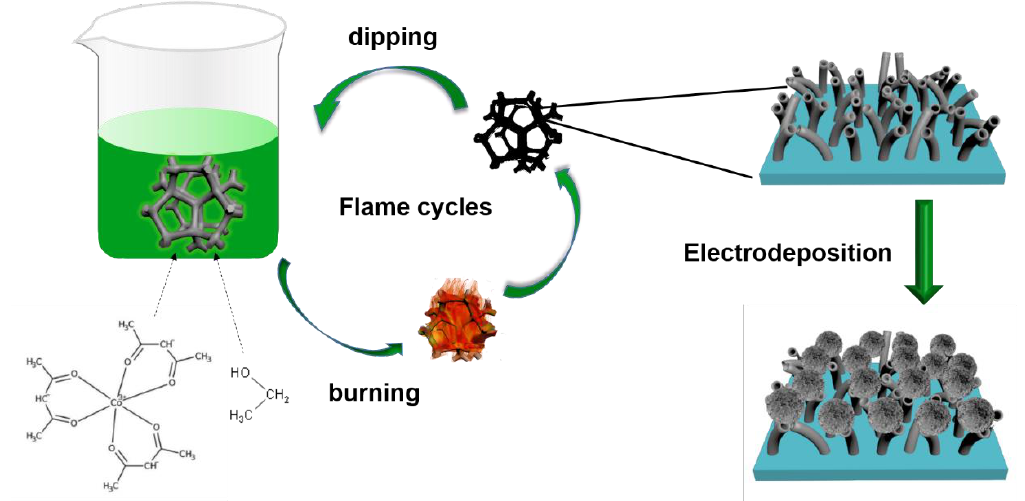
Scheme 1. Schematic diagram of the process to prepare the CoSe/Co 3 O 4 -CNTs/NF